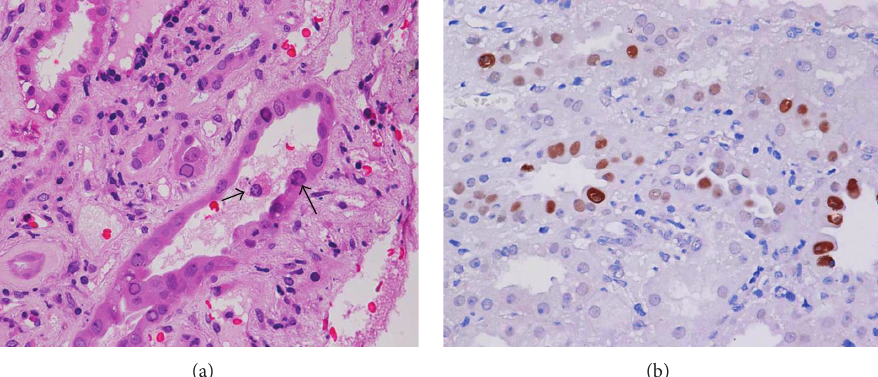
Figure 1: (a) BK virus allograft nephropathy. The histological manifestations are characterized by intranuclear viral inclusions in tubular epithelial cells and epithelial cell necrosis (arrow). Hematoxylin and eosin stained paraffin section. (b) Immunohistochemical staining of a renal biopsy showing positive staining for the BK T